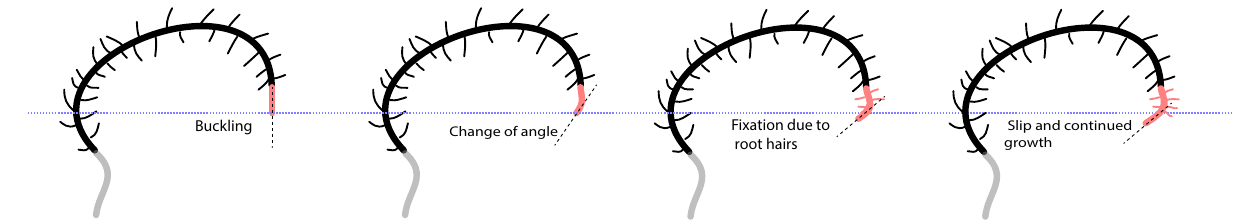
Figure 8. A growth and buckling step giving rise to a circular growth pattern. Each step starts with a buckling event, that causes a small change of angle. This small change of angle is fixed to the gel by the advancing root hairs that causes the free zone to become shorter and “straighter”. However, the FMZ does not become completely straight and when it grows and buckles again, it tends to bend in the same direction in the absence of the symmetry breaking component of the force applied by the root